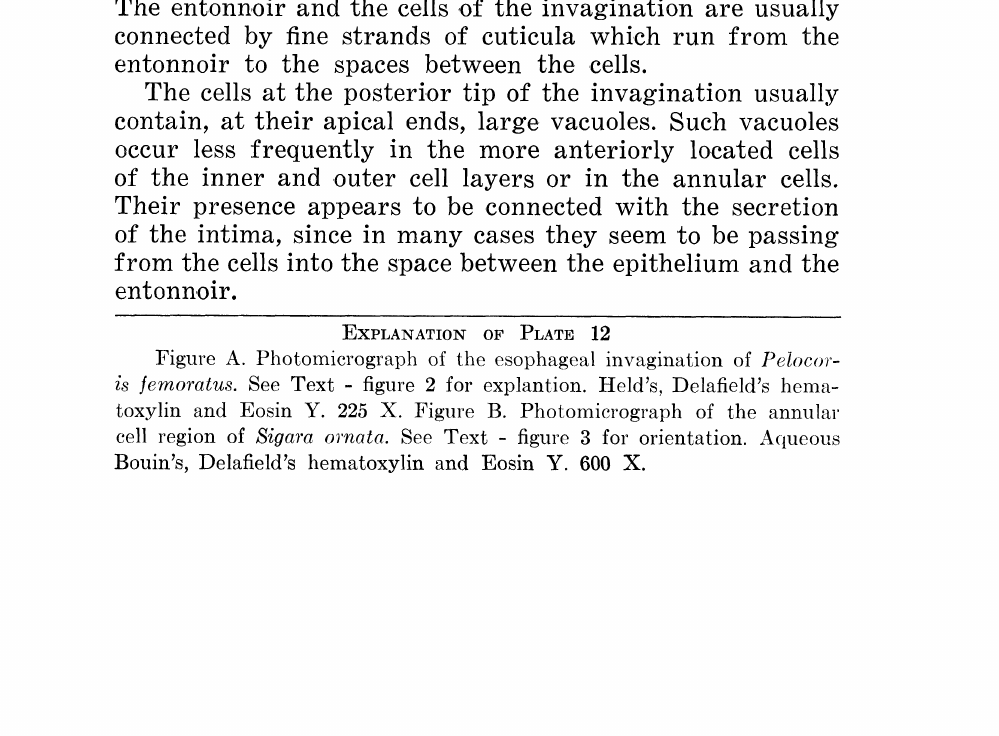
Figure A. Photomicrograph of the esophageal invagination of Pelocor- is ]emoratus. See Text- figure 2 for explantion. Held’s, Delafield’s hema- toxylin and Eosin Y. 225 X. Figure B. Photomicrograph of the annular cell region of Sigara ornata. See Text- figure 3 for orientation. Aqueous Bouin’s, Delafield’s hematoxylin and Eosin Y. 600